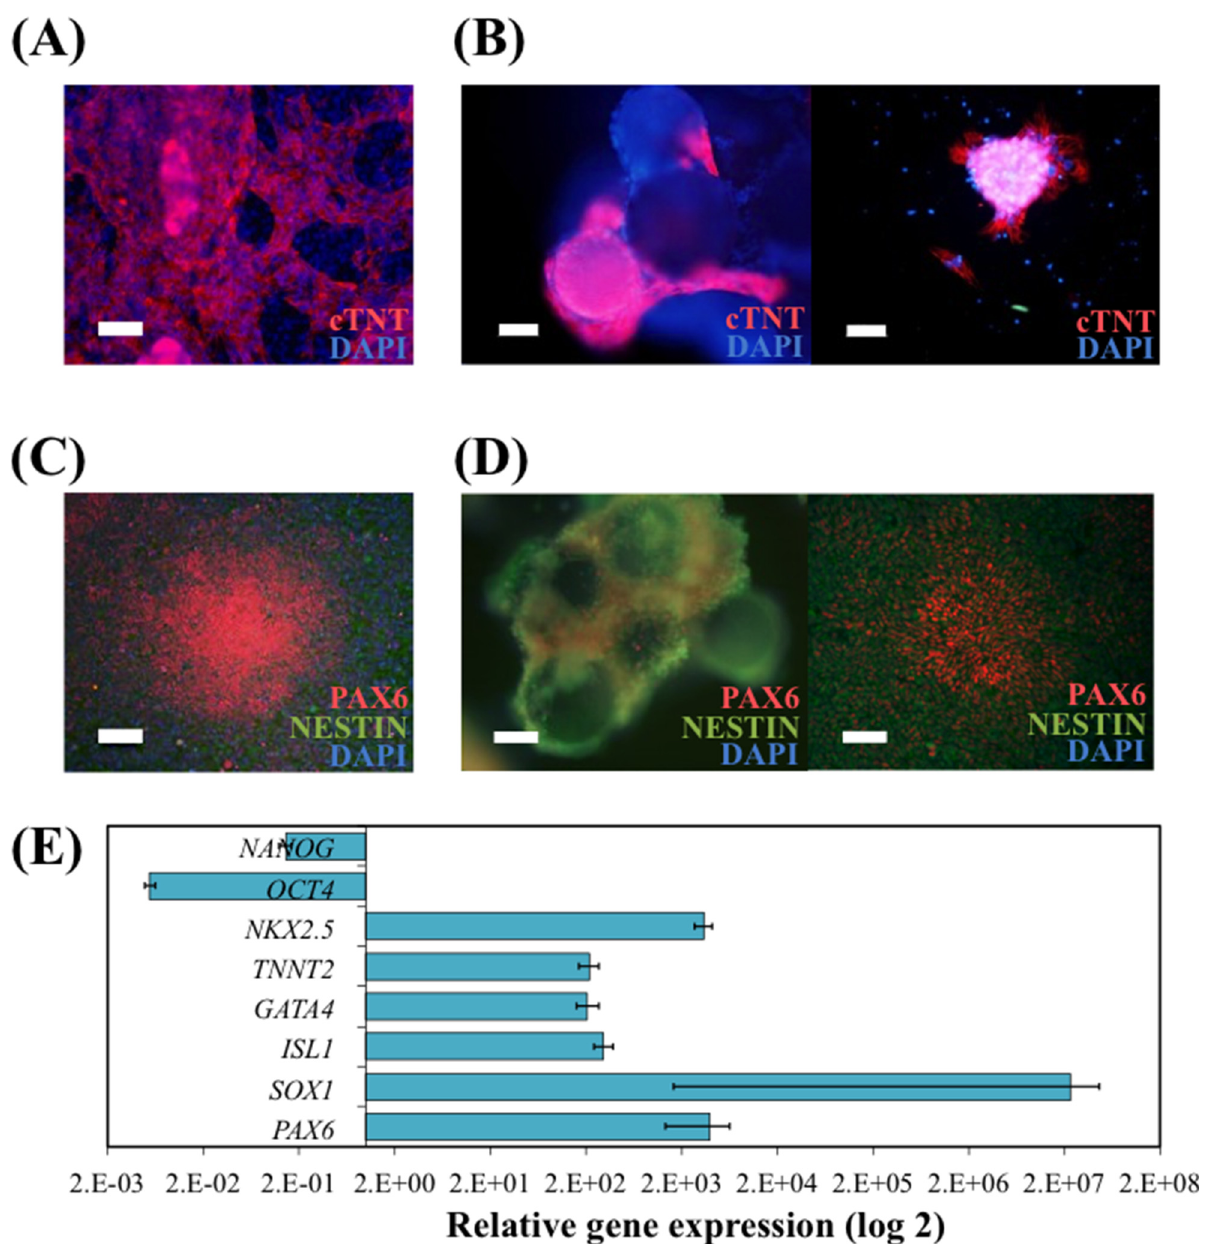
Fig 5. hiPS cells cultured in spinner flasks with E8 medium and VtnM retain their differentiation potential. Cardiomyocyte (CM) differentiation was performed using Life Technologies Cardiomyocyte Differentiation Kit (A) of hiPS cells harvested from microcarriers and re-plated on GP. Immunostaining depicting CM for the cTNT marker. Nuclei were counterstained with DAPI. Scale bar – 100 μ m; and (B) of hiPS cells on VtnM in static conditions in a low attachment plate. Immunostaining for the cTNT marker depicting CM on microcarriers (left panel) and plated CM on GP after differentiation protocol (right panel). Nuclei were counterstained with DAPI. Scale bars – 50 μ m. Neural induction by Dual-SMAD inhibition (C) of hiPS cells harvested from microcarriers and re-plated on GP. Immunostaining depicting neural progenitor (NP) cells for the neuroectoderm markers PAX6 and NESTIN. Nuclei were counterstained with DAPI. Scale-bar: 100 μ m; and (D) of hiPS cells on VtnB in static conditions in a low attachment plate. Immunostaining for the neuroectoderm markers PAX6 and NESTIN depicting NP cells on microcarriers (left panel) and plated NP cells on GP after differentiation protocol (right panel). Nuclei were counterstained with DAPI. Scale bars – 50 μ m. (E) Quantitative RT-PCR analysis of differentiated hiPSC cultured in spinner flask, subject to cardiomyocytes or neural differentiation. The relative expression of each gene was measured against the same gene prior to